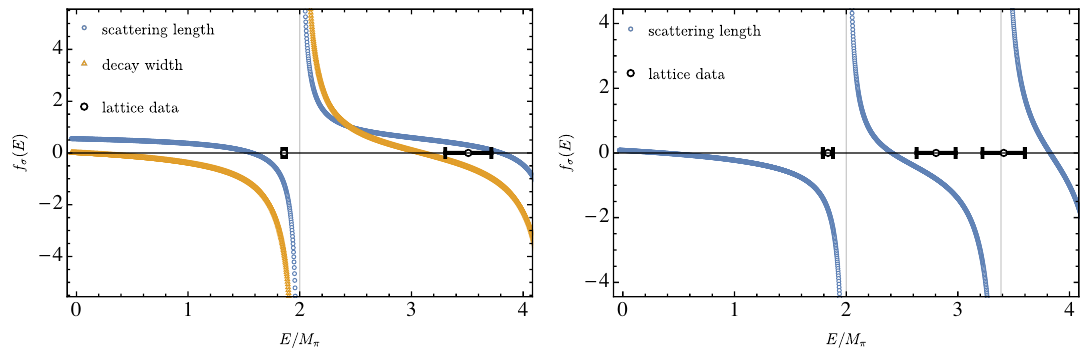
Figure 2 . Predicted energy levels (zeroes of f σ ( E ) ) of the ππ -system within the σ -dimer approach using Set 1 (7.12) (left panel) and 2 (7.13) (right panel). The blue curves show the function f with h determined from the two scattering lengths a I =0 M 2 shows f ( E ) with h determined from the decay width Γ σ 2 lattice results with errors from ref. [22] and the grey vertical lines the non-interacting ππ energy